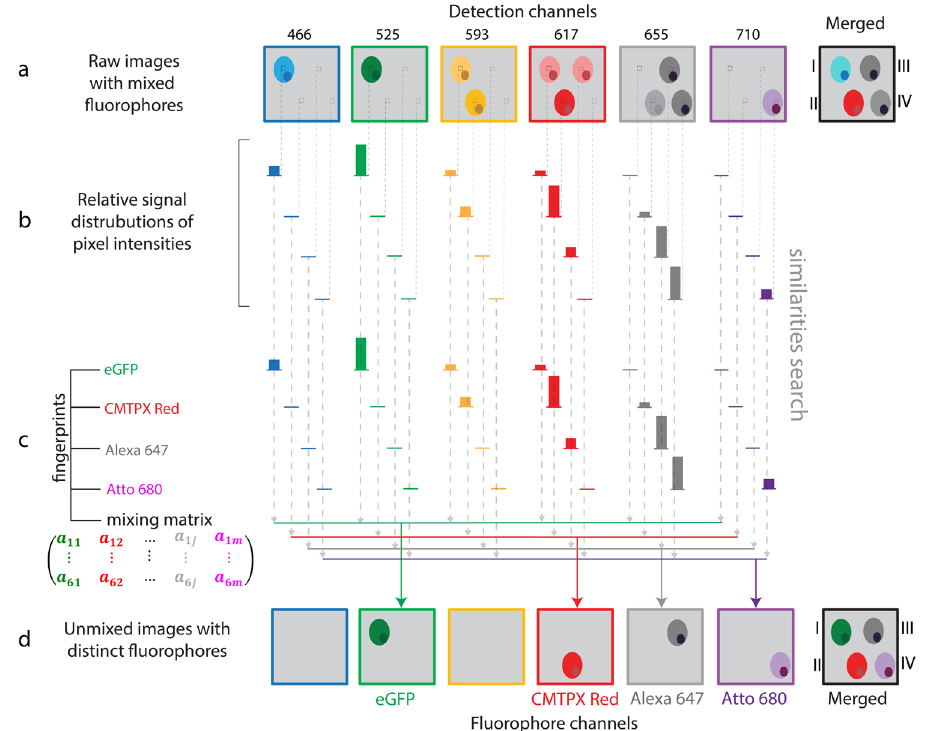
Figure 3. Principle of similarity unmixing algorithm. ( a ) Raw images of cellular objects show crosstalk in six detection channels. The merged image illustrates color ambiguity of four cells labelled from I to IV. ( b ) The algorithm extracts a relative signal distribution from six channels pixel by pixel. ( c ) The fingerprints of eGFP, CMTPX Red, Alexa647, Atto680 are measured from single-labeled cells. The algorithm searches for similarities between the signatures of undefined fluorophores from ( b ) and the known fingerprints channel by channel (dashed arrows). ( d ) Unmixed images with separated distinct fluorophores. The closest match with one of the fingerprints indicates similarity of the undefined fluorophore from ( c ) with the fluorophore of this fingerprint. The determined fluorophore signal is collected in the distinct fluorophore channel (colored arrows). As a result, color separation of the cells I–IV is achieved in the merged image from the fluorophore